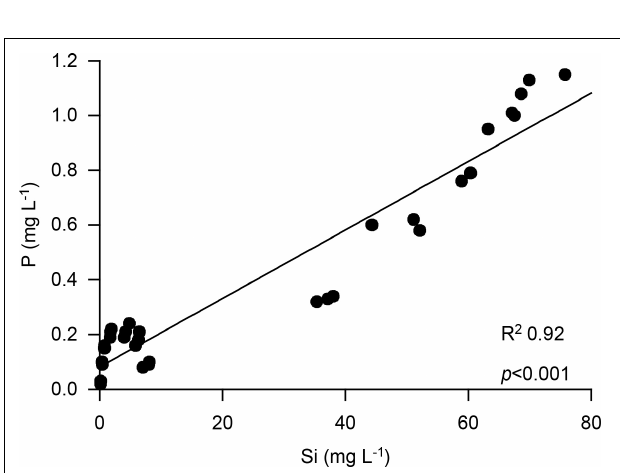
FIGURE 5 | Correlation between P and Si mobilization from soil collected from a mobilization